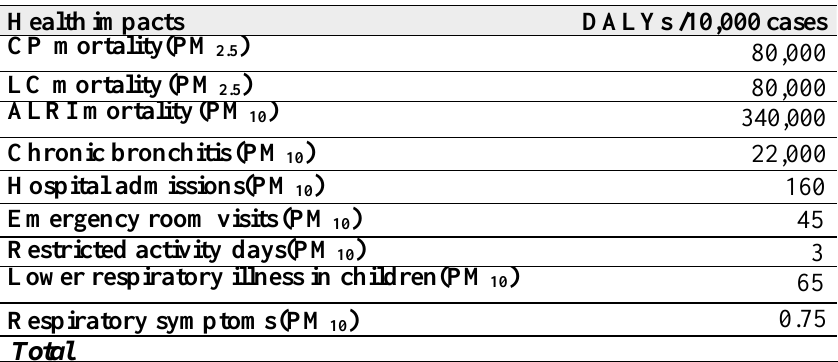
Table 1. Estimated health impacts of air pollution, urban and